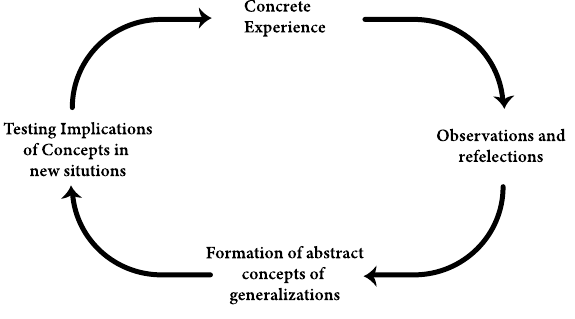
Figure1: Lewin's EL cycle (1951) as cited by Kolb (1984)